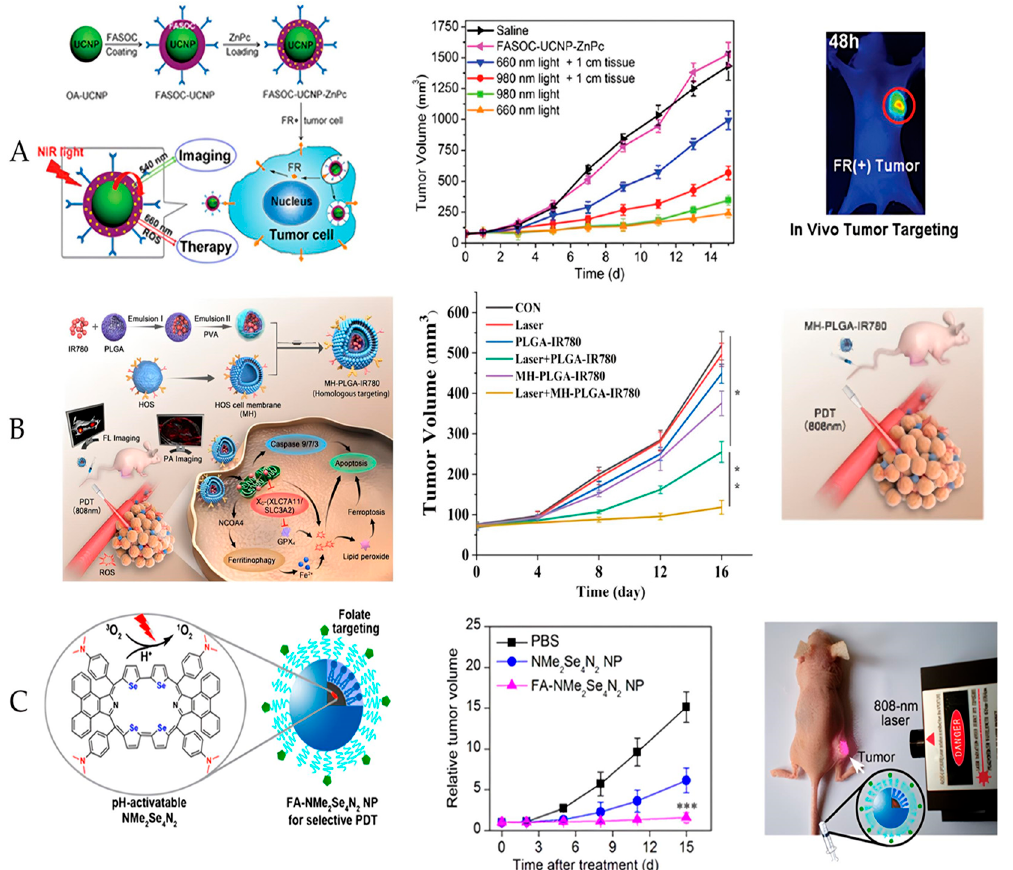
Figure 3. Schematic illustration of the main studies involving new types of PS for application in cancer PDT. ( A ) Synthesis of the FASOC-UCNP-ZnPc nanoconstruct and folate-mediated binding of tumor cells with folate receptor expression. Comparison of the therapeutic efficacy of deep tissue PDT triggered by 980 and 660-nm light. ( A ) Tumor growth of mice in different treatment groups within 15 days. Adapted from [51]. Reproduced with permission from the American Chemical Society, Copyright © 2013. ( B ) Construction of the MH-PLGA-IR780 NPs and the specific killing mechanism of the targeted theranostic nanoplatform-mediated PDT approach. The tumor volume was measured during the therapeutic period. (The data are presented as the mean ± SD values; n = 5, * p < 0.05, and ** p < 0.01.) Adapted from [58]. Reproduced with permission from Springer Nature, Copyright © 2022. ( C ) Targeted PDT on a Hela tumor-bearing mouse intravenously injected with FA-NMe2Se4N2 NPs. Change of relative tumor volume (V/V0) after mice were intravenously injected with PBS, NMe2Se4N2 NPs, or FA-NMe2Se4N2 NPs and irradiated with a 808-nm laser at 100 mV cm − 2 for 30 min. Data are the means ± SD (6 mice per group), *** p < 0.001 compared to other groups using a one-way ANOVA. Adapted from [57]. Reproduced with permission from the American Chemical Society, Copyright ©